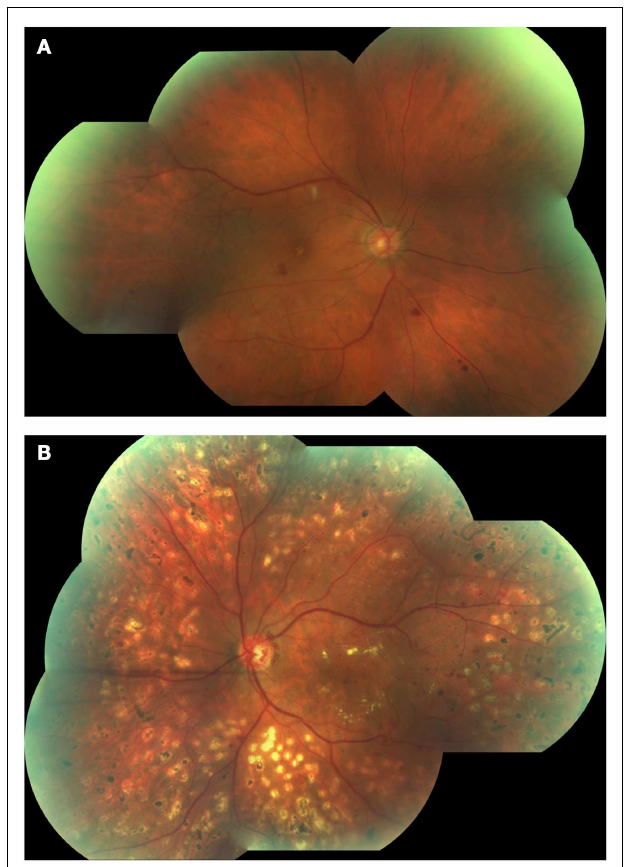
FIGURE 1 | Fundus photographs obtained from patients with non-proliferative diabetic retinopathy (NPDR) (A) and proliferative diabetic retinopathy (PDR) (B) . Note few hemorrhages and a cotton wool spot at the superior aspect of the macula in (A) , and marked neovessels in the disc and macular exudation in (B) .